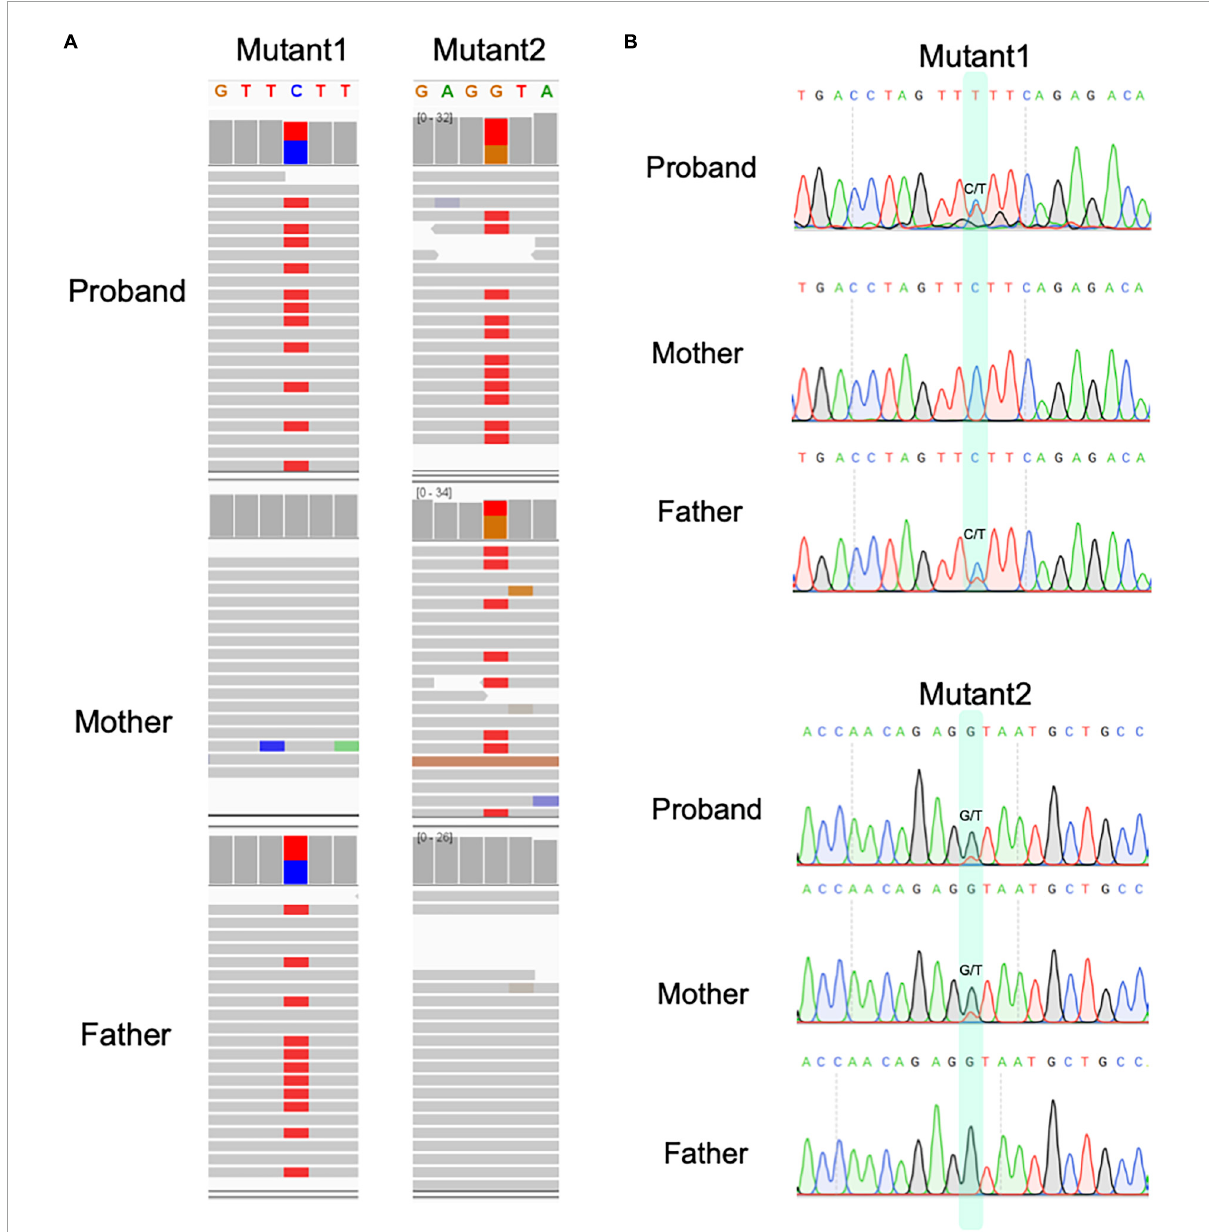
FIGURE3 The compound heterozygous variants identified from proband of microcephaly in this study. (A) The compound heterozygous variants in proband and their parental origin based on genomic sequencing and IGV. (B) The Sanger sequencing for two variants in three individuals.